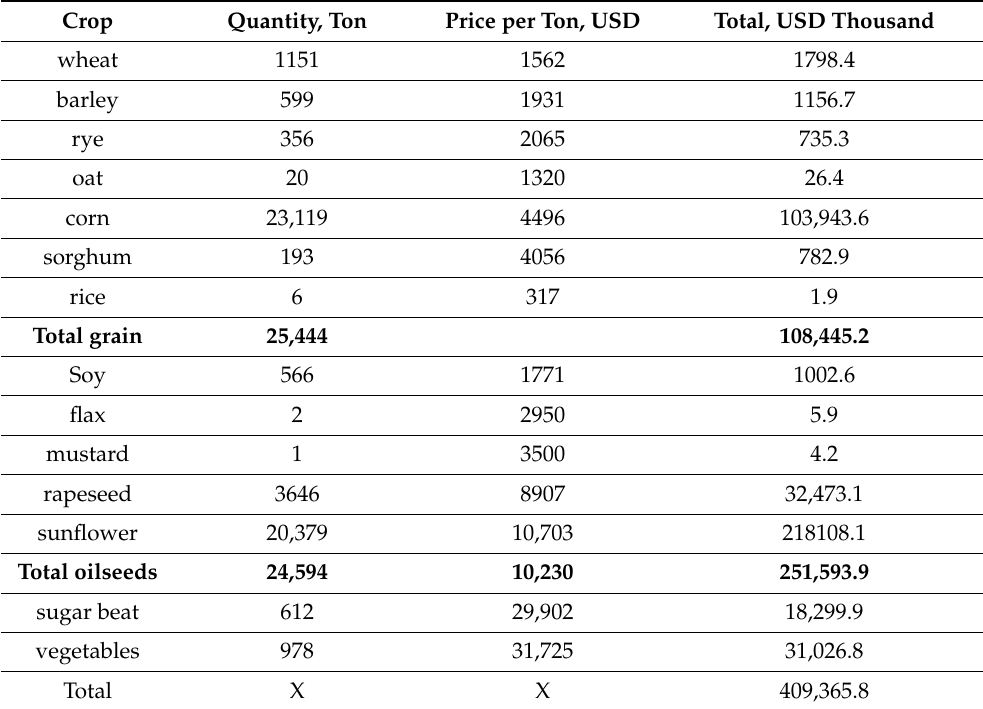
Table 3. Import of grain crops and oilseeds in 2020. Crop Quantity, Ton Price per Ton, USD Total, USD Thousand